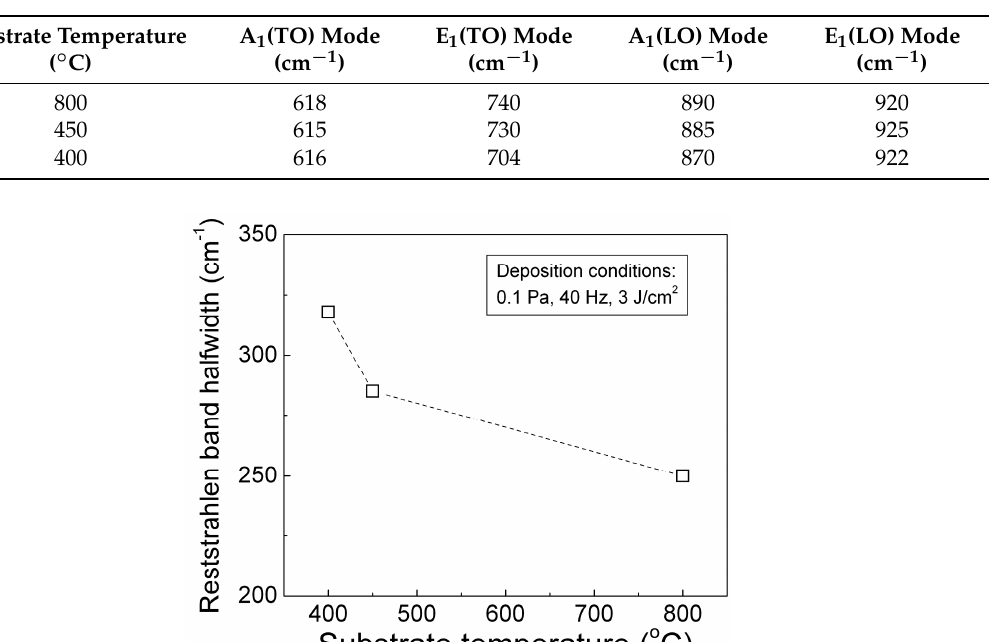
Table 1. Peak position of the phonon-polariton modes in the Reststrahlen band, registered with p -polarized radiation in the AlN films (Figure 8a). TO, transverse.